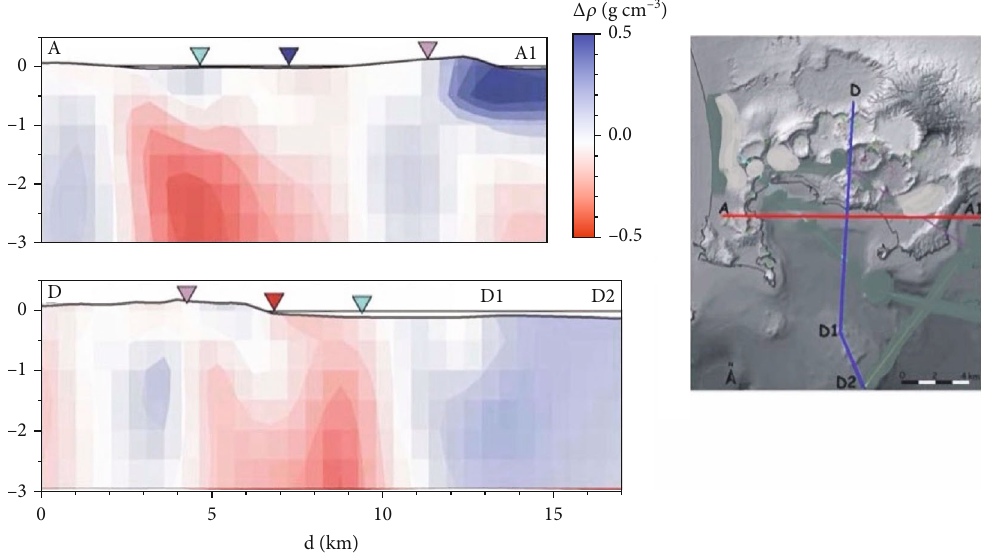
Figure 8: Selected vertical density cross-sections. Locations of the plotted sections are shown in the small map on the right. Color scale represents density contrasts (g/cm 3 ) (modi fi ed from Capuano et al.